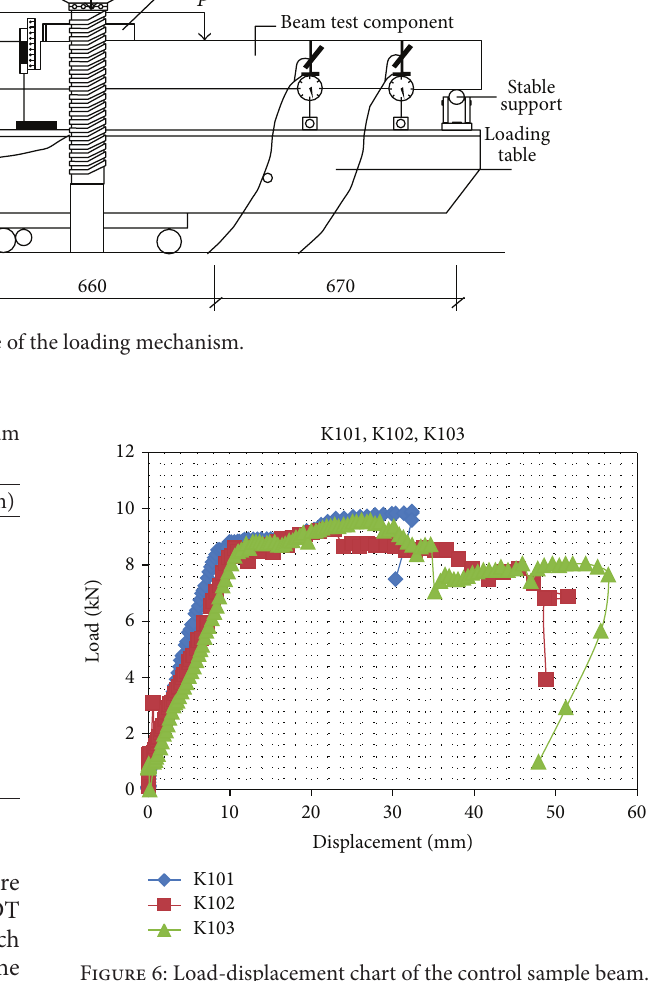
Figure 6: Load-displacement chart of the control sample